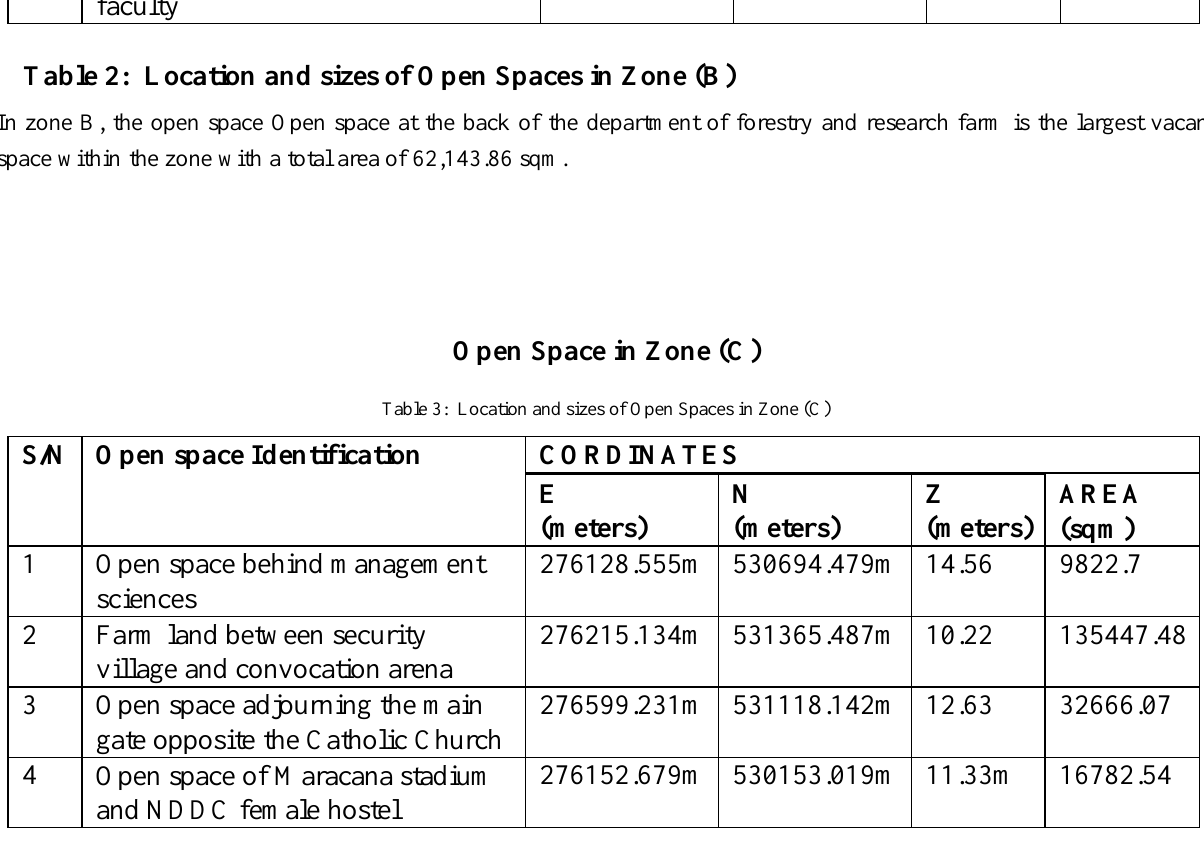
In zone C, Open space adjourning the main gate opposite the Catholic Church is the largest vacant space within the zone with a total area of 32,666.07